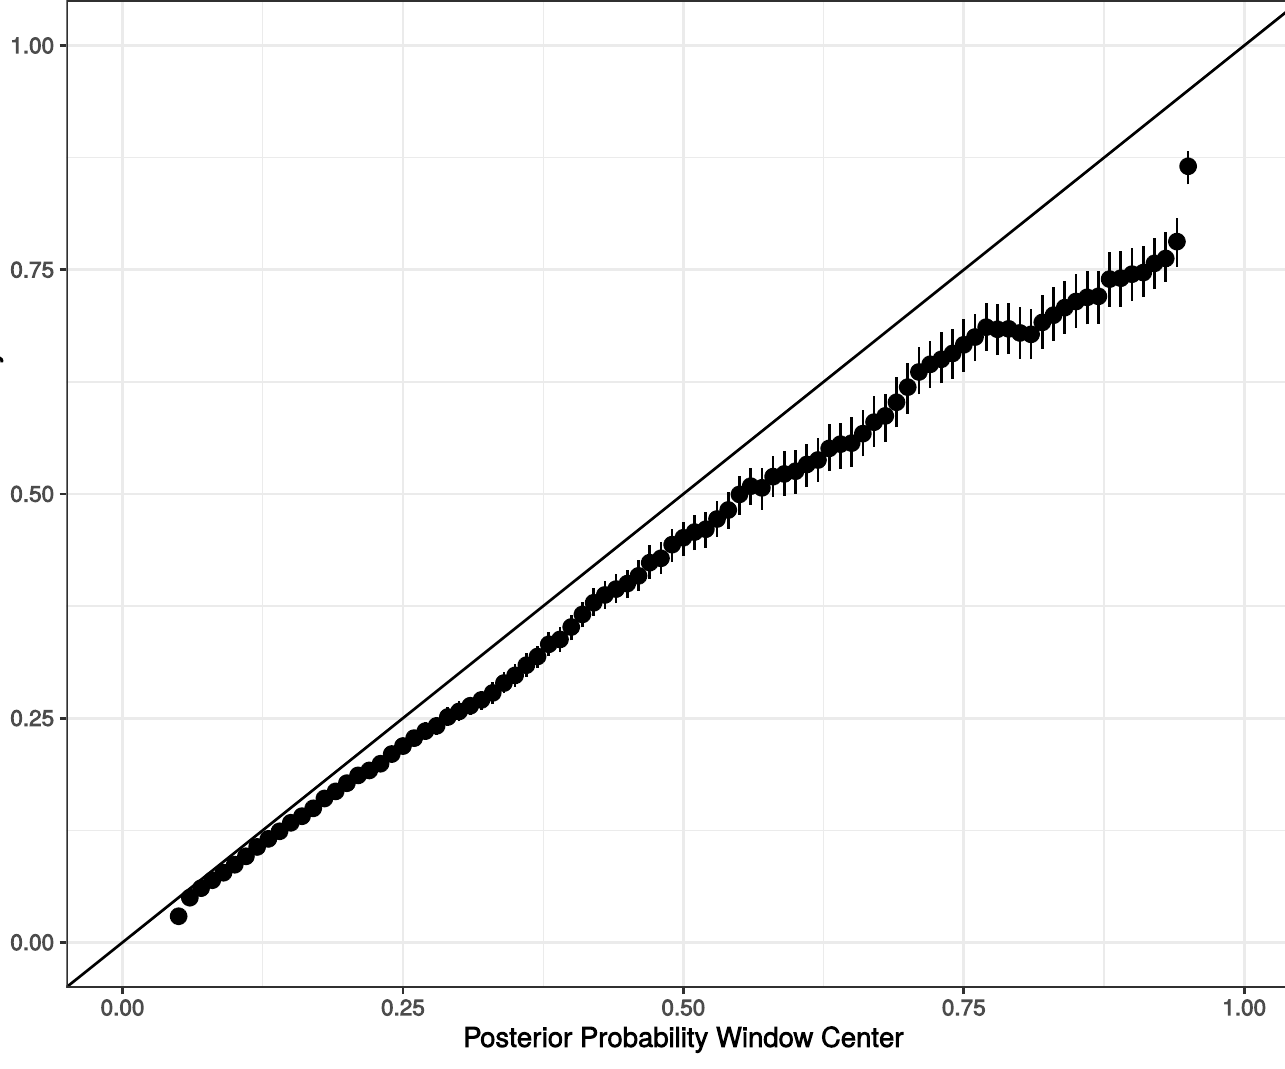
Fig 7. Relationship Between True Infector Probability and Inferred Posterior Probability. Dots with error bars show the probability that a potential infector is the true infector of an individual, given that the inferred posterior probability for that potential infector is within a window of width 0.10 centered at a certain value. The y = x line is shown for comparison. Data for this figure is from the 1000 trials used for testing the effect of biomarker information. Error bars indicate the 95% bootstrapped confidence interval for each window.